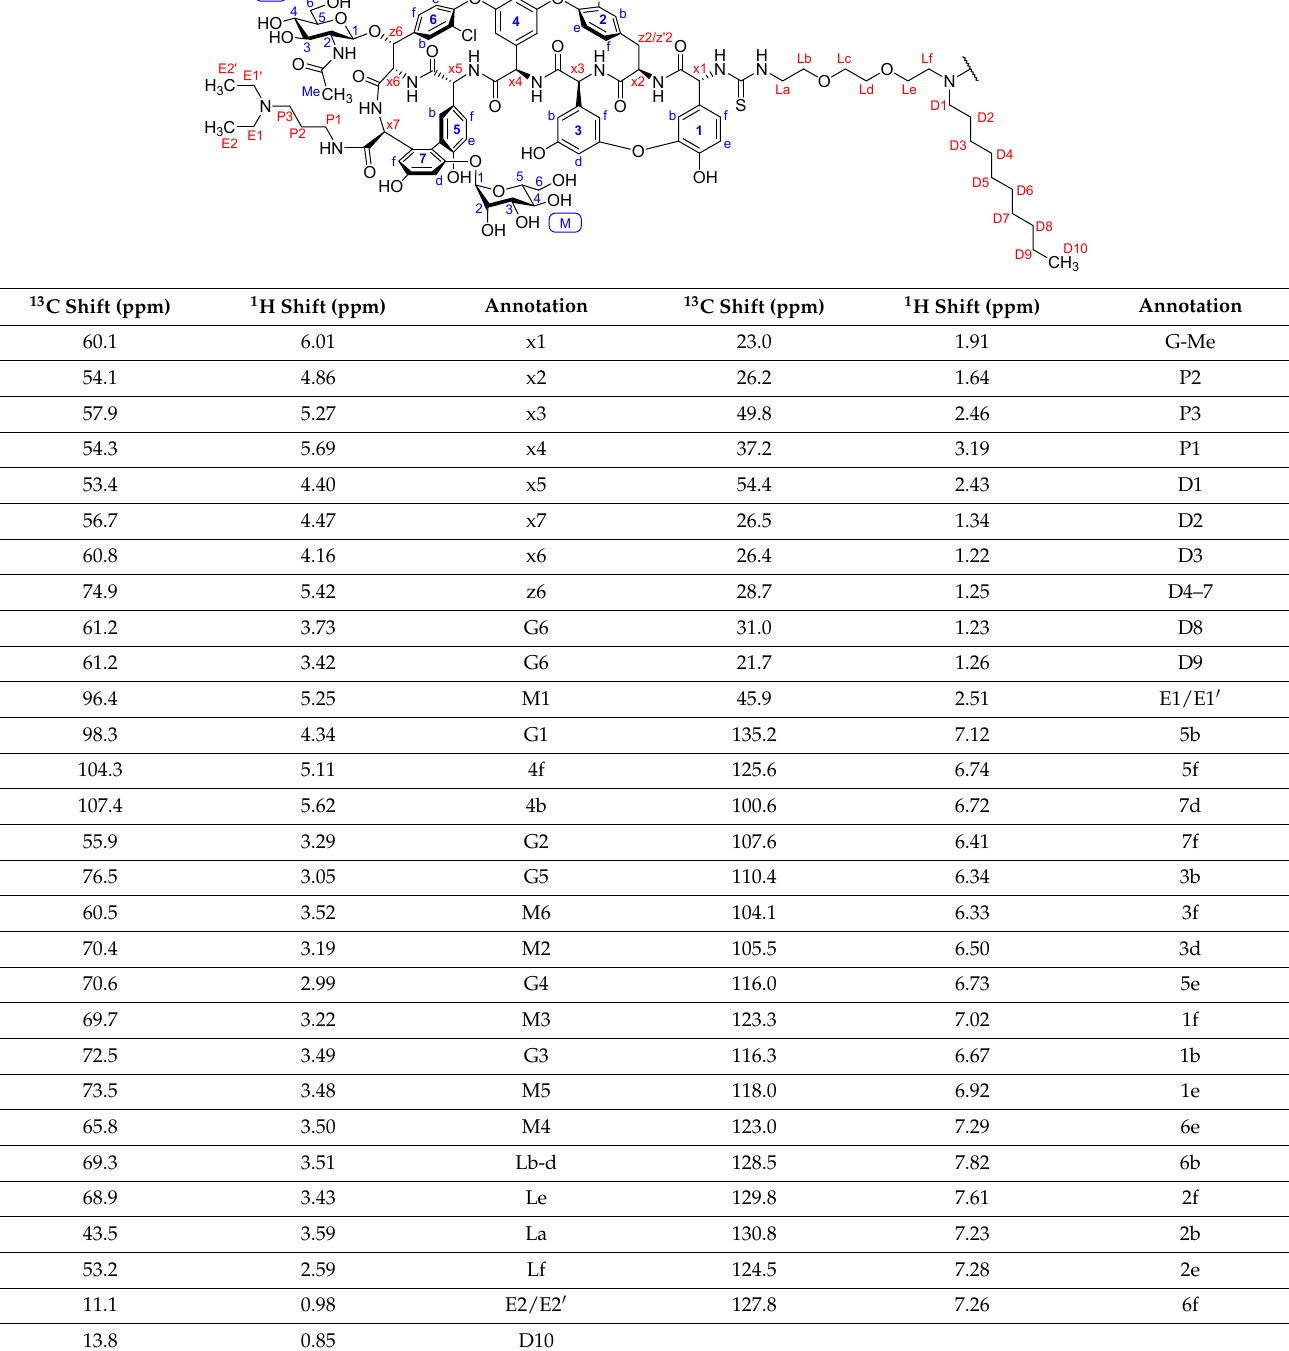
Table 3. NMR data of 13 .